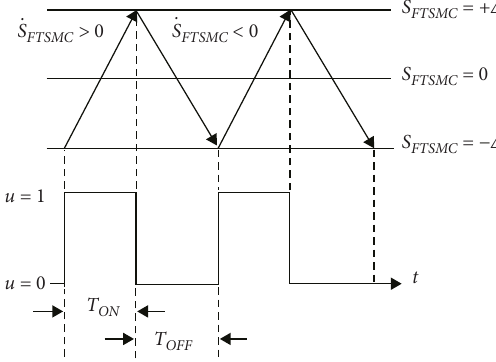
Figure 7: Hysteresis modulated sliding